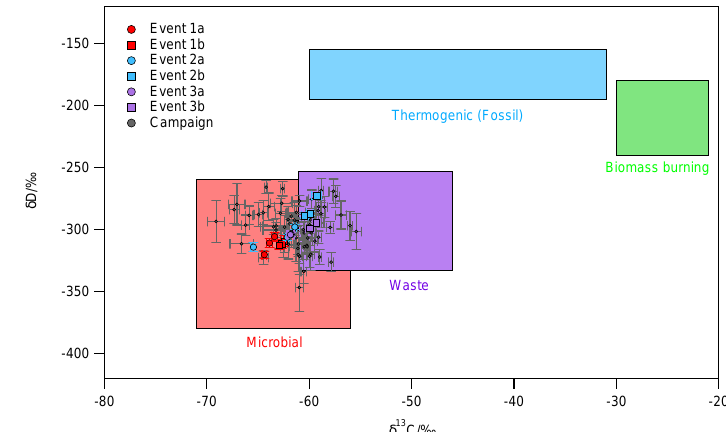
Figure 7. MKP intercepts of δ D vs. δ 13 C. The colored areas indicate typical isotope signatures for different source categories. Circles show the 6h-averaged source signatures. Large colored symbols indicate data from the three events (event 1: 10–12 March; event 2: 16–18 March; event 3: 22–24 March) that are highlighted in Fig. 9. The labels a and b refer to day 1 and day 2 of the 2-day events, respectively. For the source signatures, the δ 13 C values are taken from Table 1 and the δ D values from recent literature (Snover et al., 2000; Rigby et al., 2012).